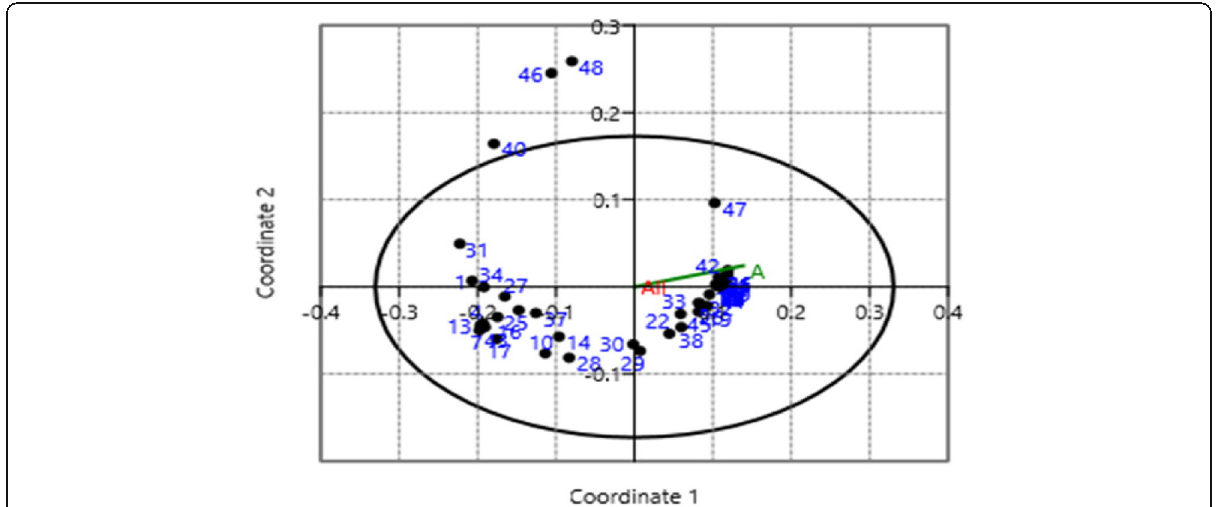
Fig. 8 NMDS scatter plot (95% eclipse) of organic acid formation in E. coli cultures for 0 h, 24 h, and 72 h treatments containing raw food items and milk using correlation as a similarity measure.(Environmental variable = time of treatment in